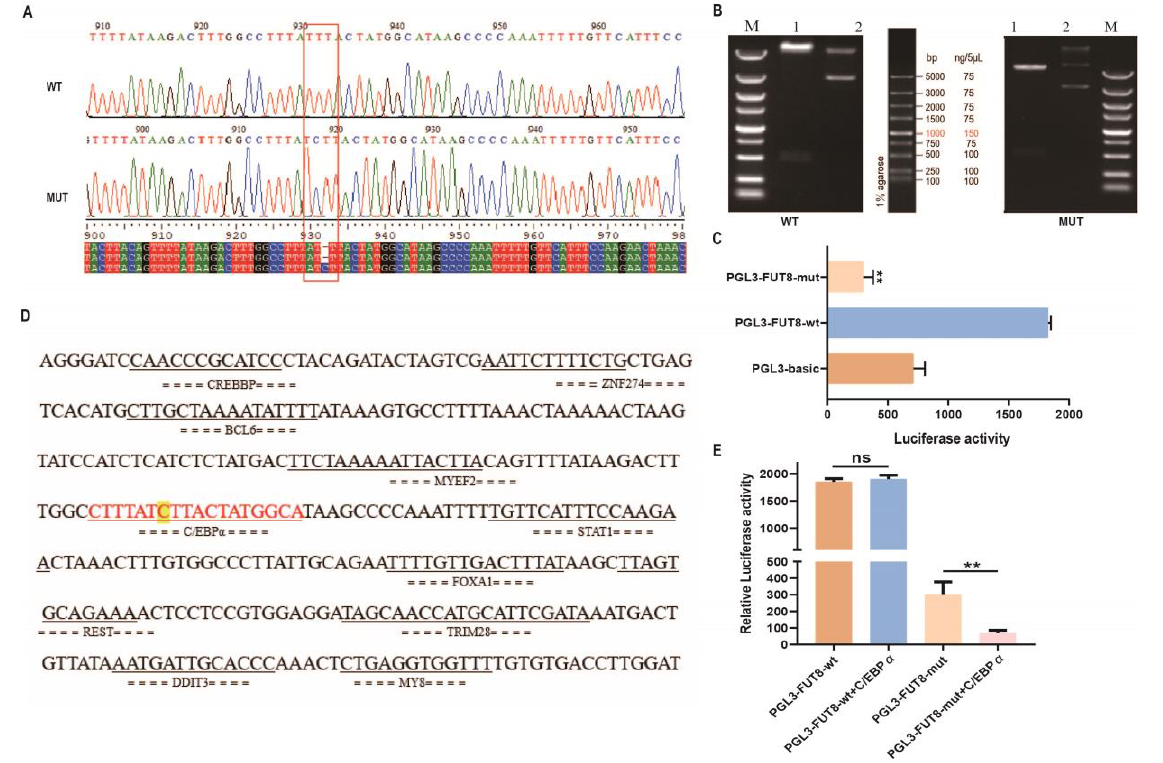
Figure 7. Promoter polymorphism and transcription factor analysis. ( A ) SNP mutation sites were identified via PCR sequencing, i.e., wild-type sequence and mutant sequences. Inserted sequences are marked with red boxes. ( B ) Mutant and wild-type sequences were verified by agarose gel. Lane 1: plasmid digested by Kpn I and XhoI ; Lane 2: plasmid DNA, Lane M: DL5000 marker. ( C ) Relative luciferase activity of wild-type (wt) or mutant-type (mut) FUT8 luciferase reporter. ( D ) Transcription factor binding sites were predicted from the insertional mutated sequences. ( E ) Effects of C/EBPα on FUT8 transcriptional activity by dual-luciferase activity assay. ns p > 0.05 and ** p < 0.01.